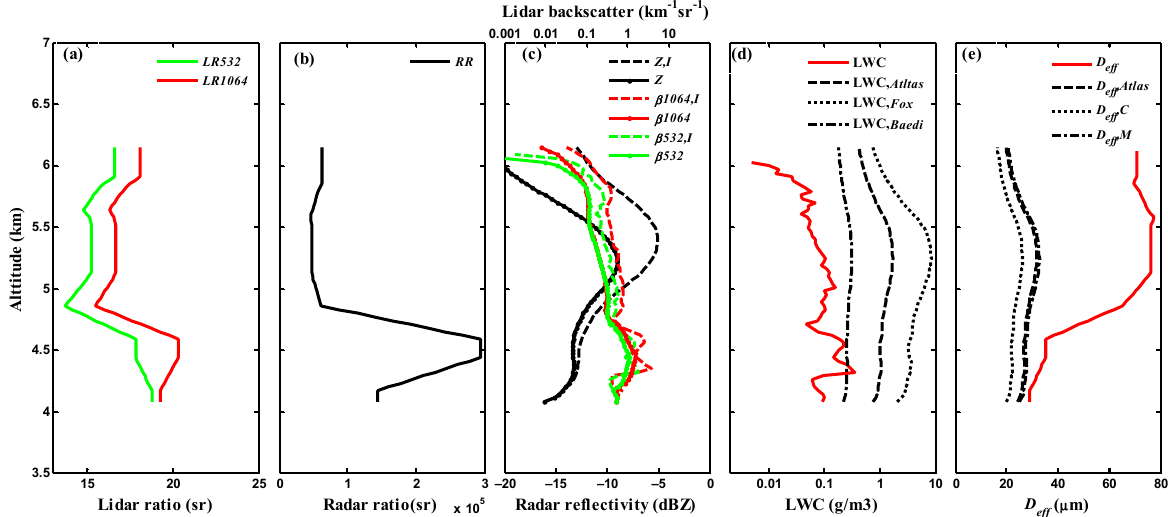
Figure 10. The inversion results at 2:30 am on 10 October 2019: ( a ) lidar ratio at different wavelengths ( LR 532 , LR 1064 ); ( b ) radar ratio ( RR ); ( c ) lidar backscatter at different wavelengths ( β 532 , β 1064 ) and radar reflectivity factor ( Z ) (initial value subscript I ); ( d ) liquid water content (LWC); ( e ) effective diameter ( D eff ) .